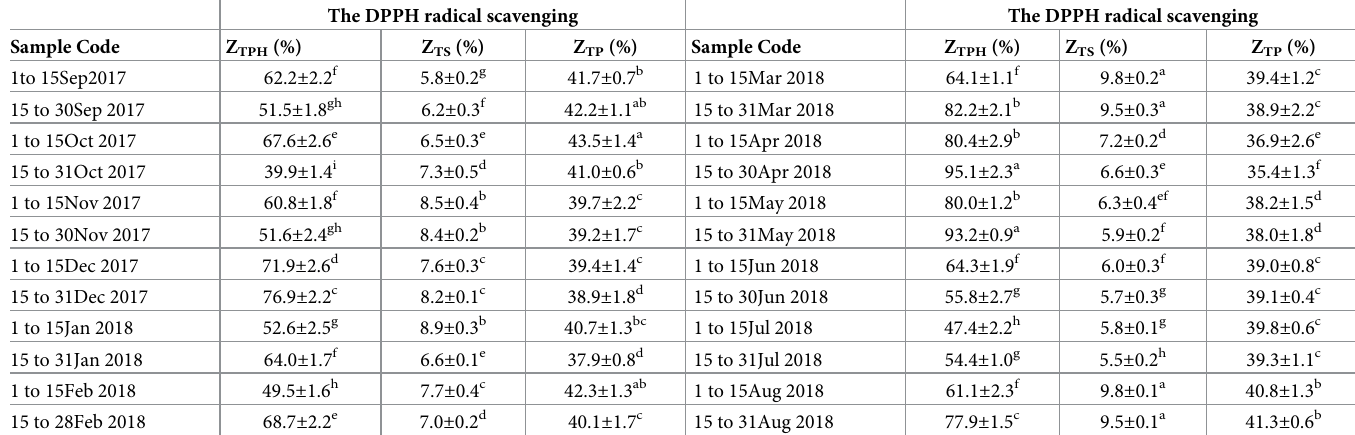
Table 2. DPPH radical scavenging rates of phenolic compounds, sterols and